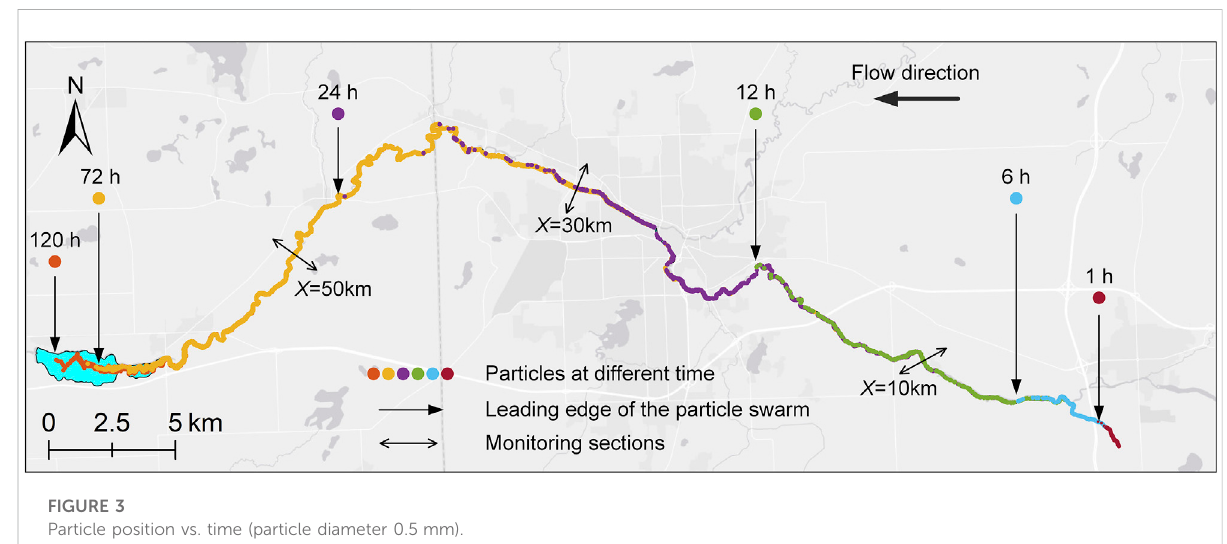
Particle position vs. time (particle diameter 0.5 mm).